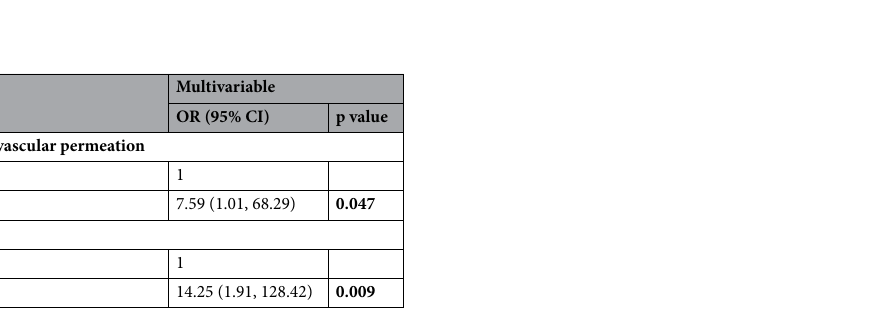
Table 4. Logistic regression for IIb metastasis in the training group. OR odds ratio, CI confidence interval.